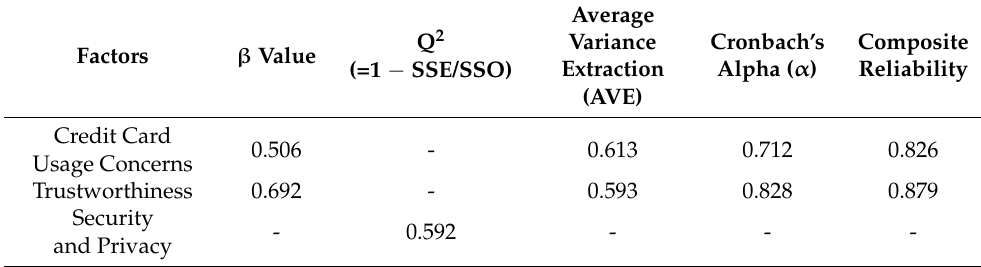
Table 4. Predictive relevance of model factors for Hunger